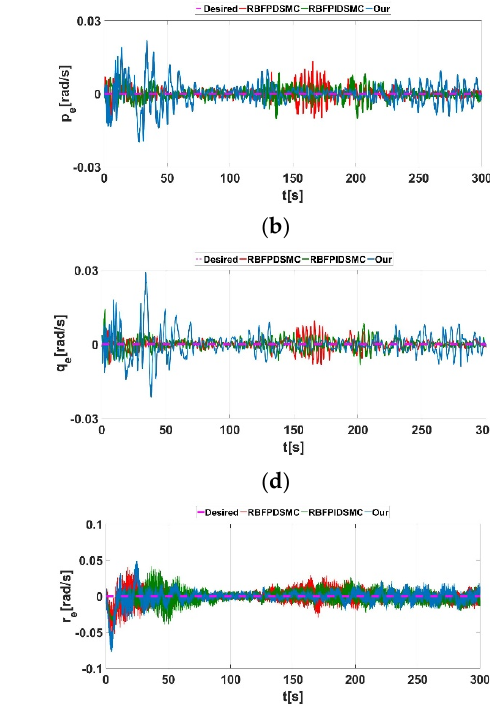
; ( c ) 𝑣 𝑒 ; ( d ) 𝑞 ; ( e ) 𝑤 𝑒 ; ( f ) 𝑟 𝑒 . 𝑒 𝑒